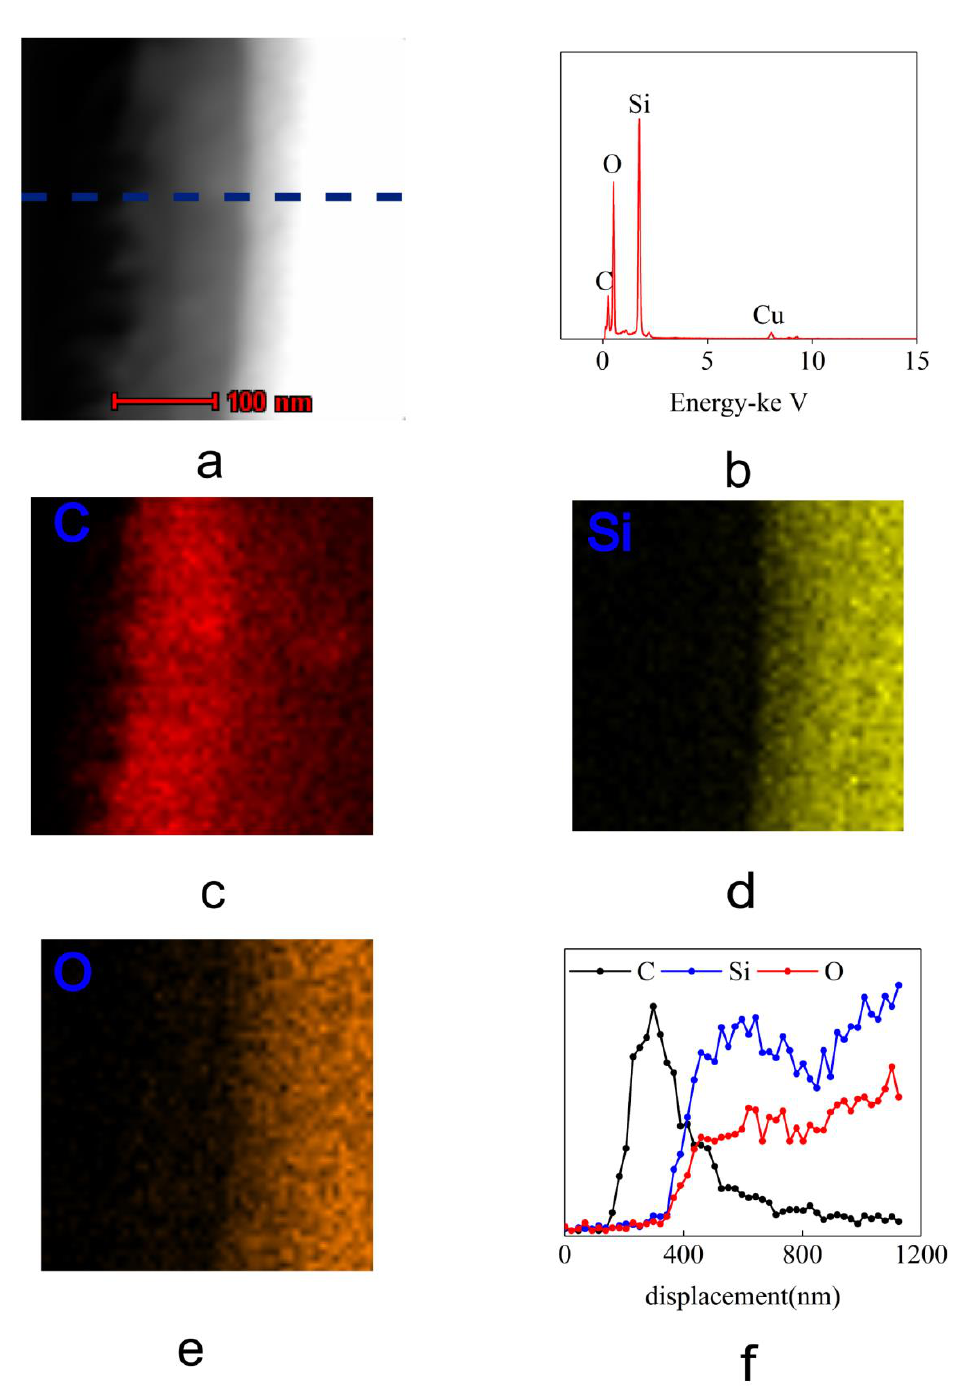
Figure 5. Energy Dispersive Spectroscopy Data of hexadecane on the inner surface of silica microtubules (ID of 2 μm). ( a ) is the high-angle annular dark-field (HAADF) imaging of the near-wall region of the microtubule after infiltration with hexadecane. ( b – e ) are the energy spectrum data and the EDS areal scans of the C, Si, O elements taken of the same area as in ( a ). ( f ) is the EDS line scans of the C, Si, O elements taken of the same area as the blue lines in ( a ).